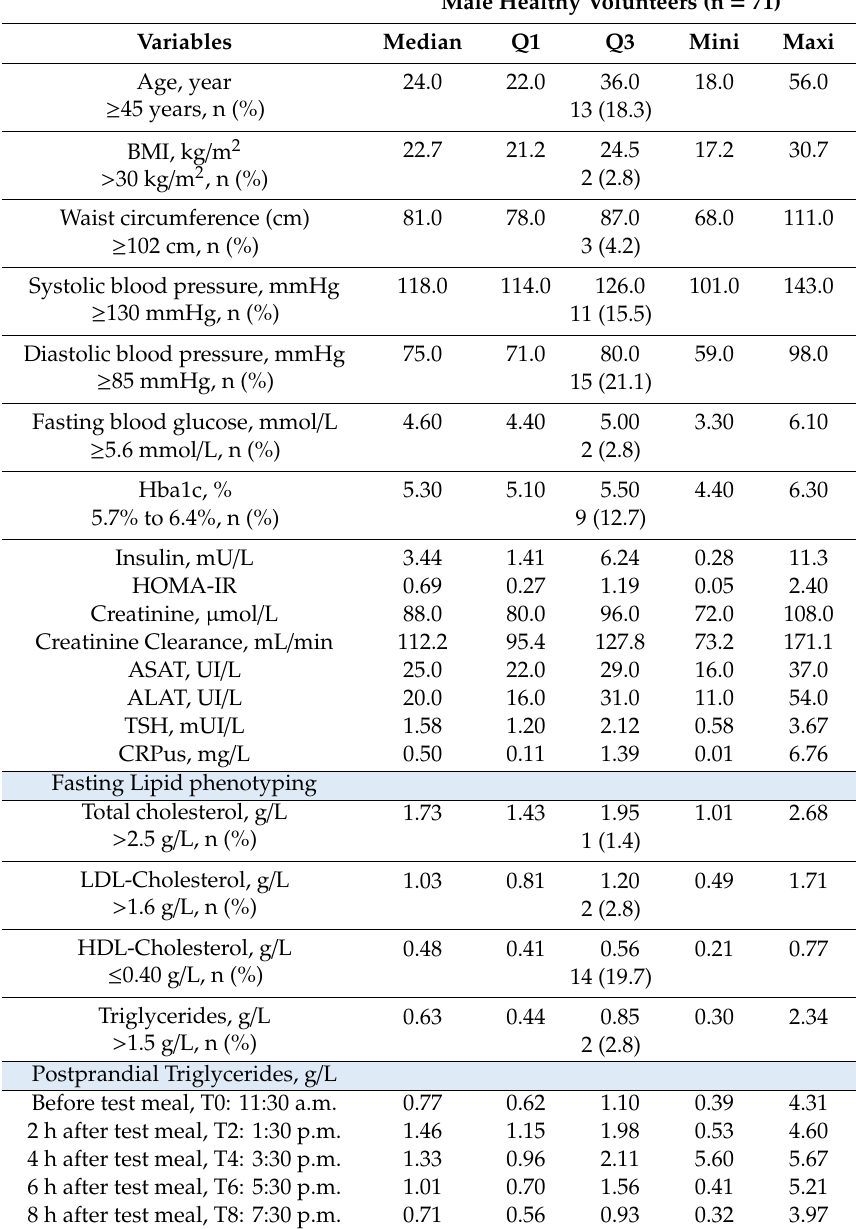
Table 1. Clinical and biological characteristic of the study